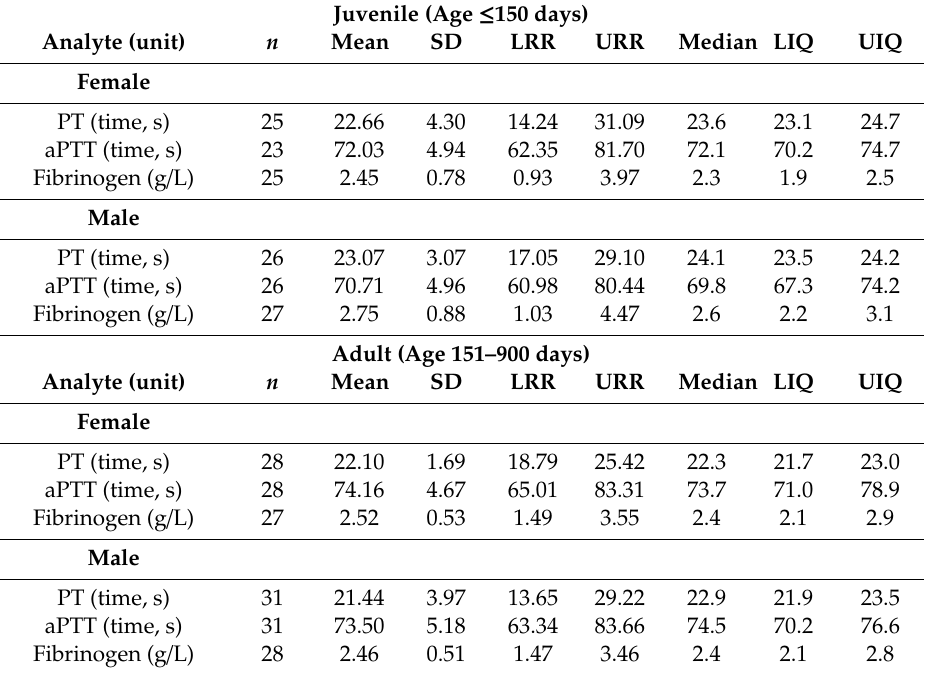
Table 1. Prothrombin time, activated partial thromboplastin time and fibrinogen reference intervals for strain 13 / N guinea